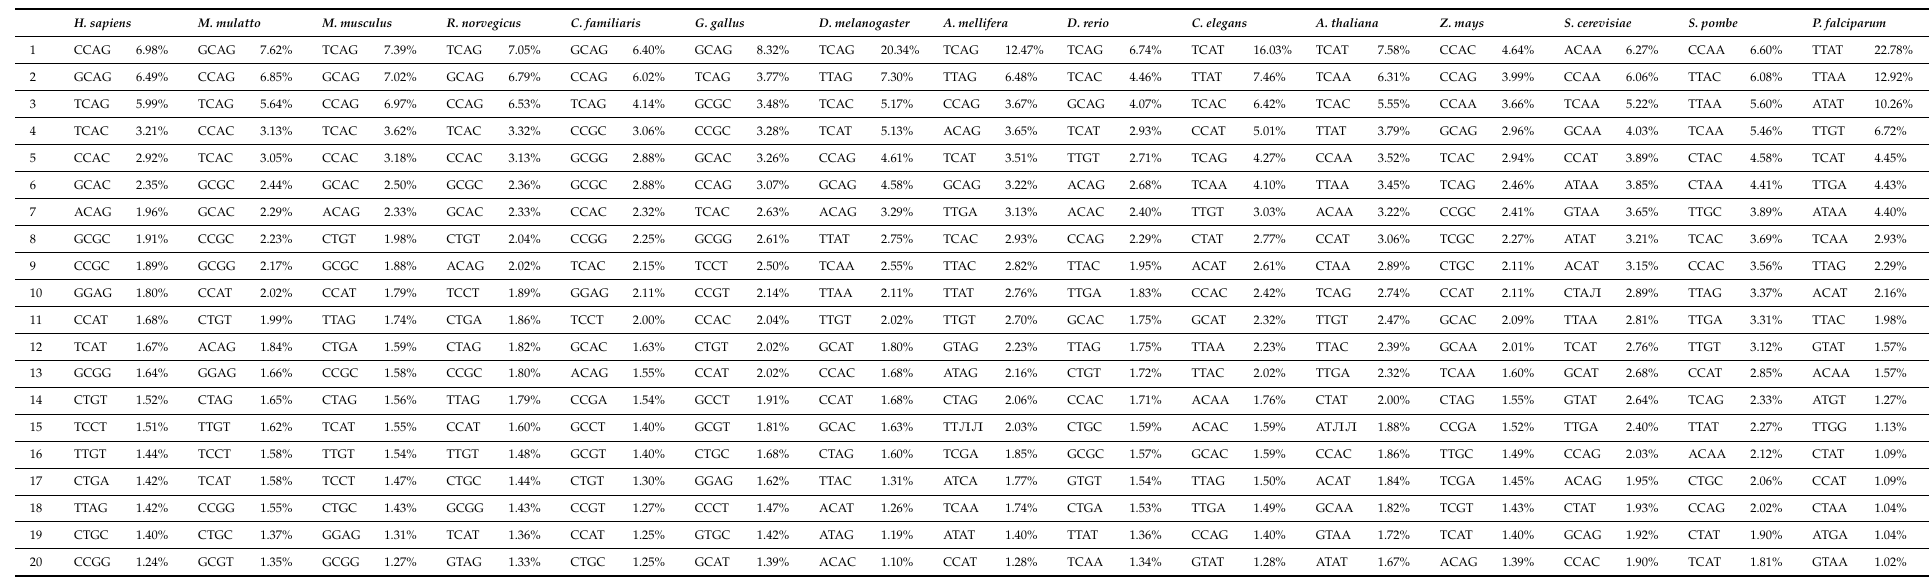
Table 4. The content (percentage) of tetranucleotides in positions − 2,